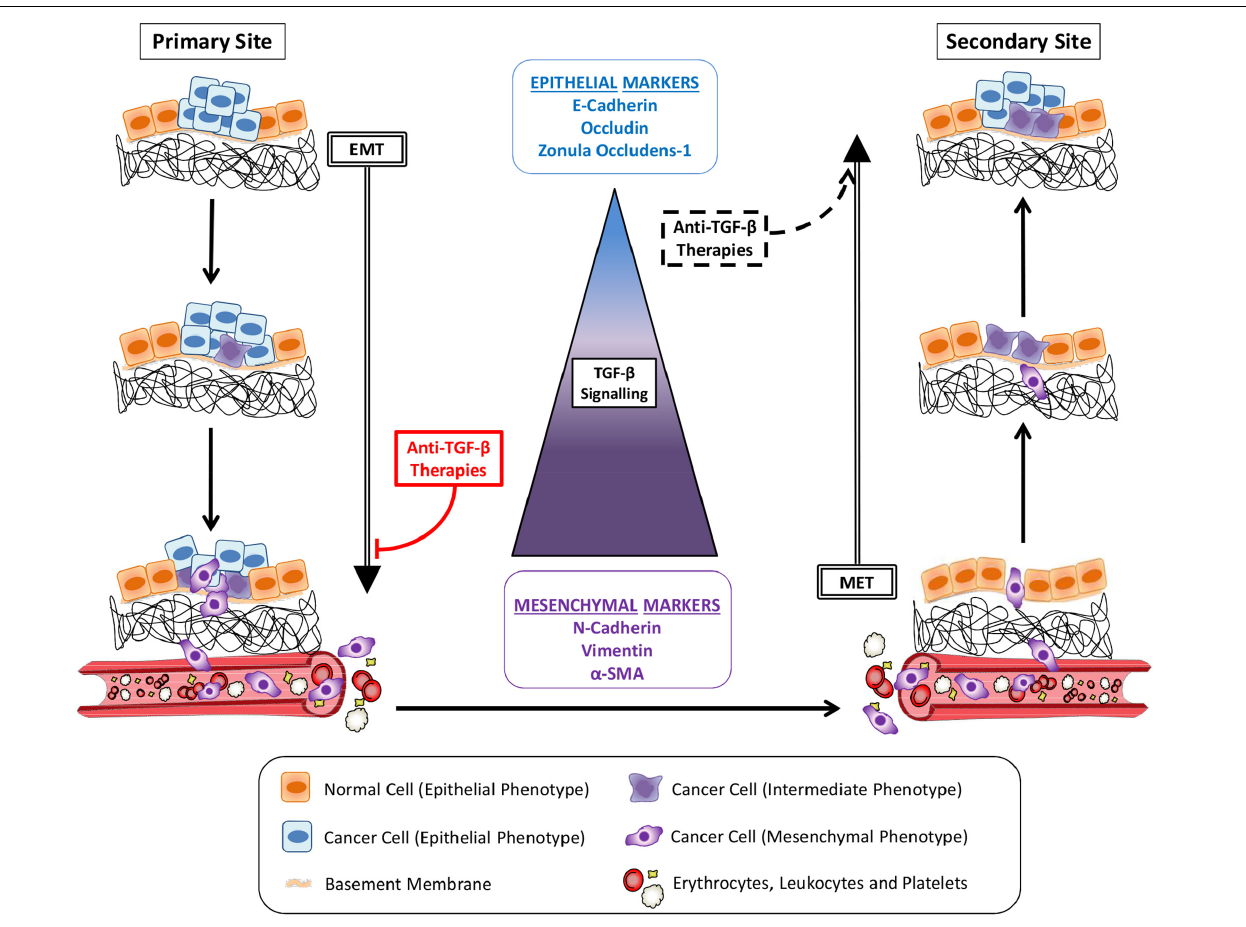
FIGURE 1 | Cancer metastasis and TGF- β signaling. Cancer cells alter their morphology through epithelial-mesenchymal transition (EMT) induced by TGF- β signaling pathway activity, increasing their migratory potential. Invading the basement membrane and the extracellular matrix, tumor cells reach the vasculature (blood or lymph vessels) and become circulating tumor cells (CTCs) after intravasation. Gradually, the magnitudes of TGF- β signaling increase dramatically to enable the EMT-invasion processes. Cancer cells reach a secondary site after extravasation. Following TGF- β signaling reduction and consequent mesenchymal-epithelial transition (MET), cancer cells colonization proceeds to the growth of a metastatic lesion. Anti-TGF- β therapies administered in early stage cancers, before initial invasion, would inhibit metastasis by avoiding EMT. The same strategies used to treat late-stage cancers would also induce MET and seeding of secondary